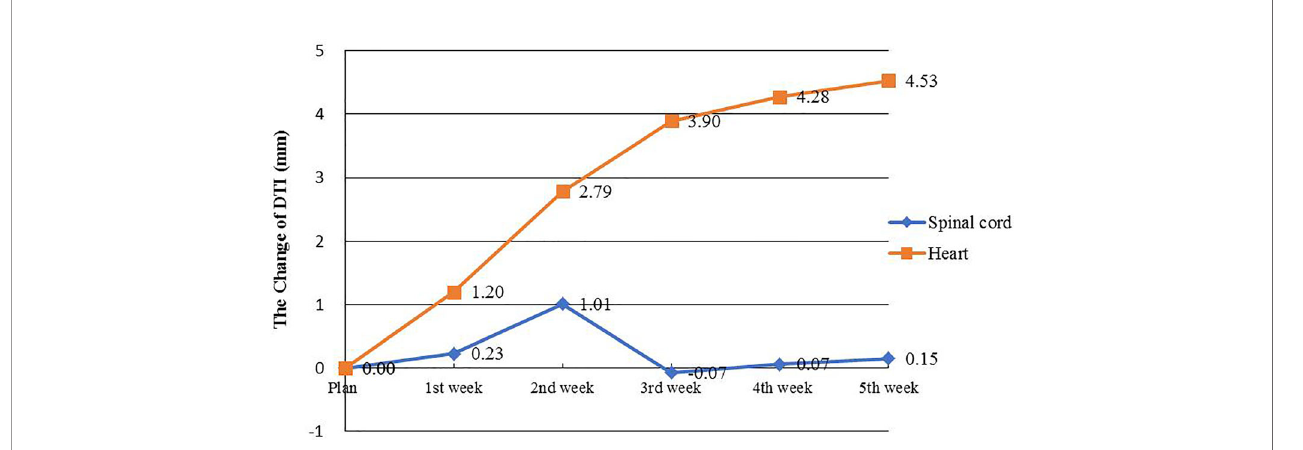
FIGURE 4 | OARs Changes of DTI. The orange line represents the change in average DTI for the spinal cord, and the blue line represents the change in average DTI for the heart.